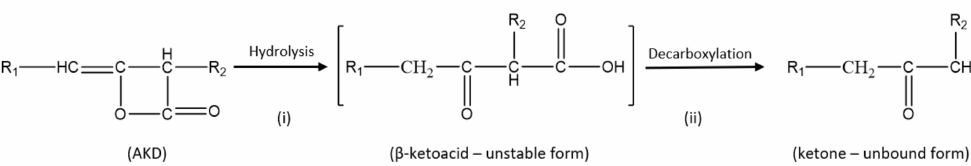
Figure 2. Hydrolysis of AKD (i) followed by decarboxylation of AKD